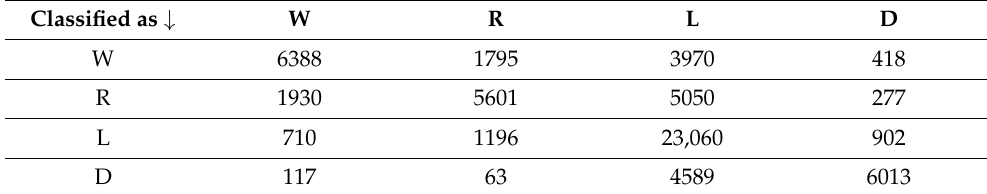
Table A1. Confusion matrix of the classification result in the test set of